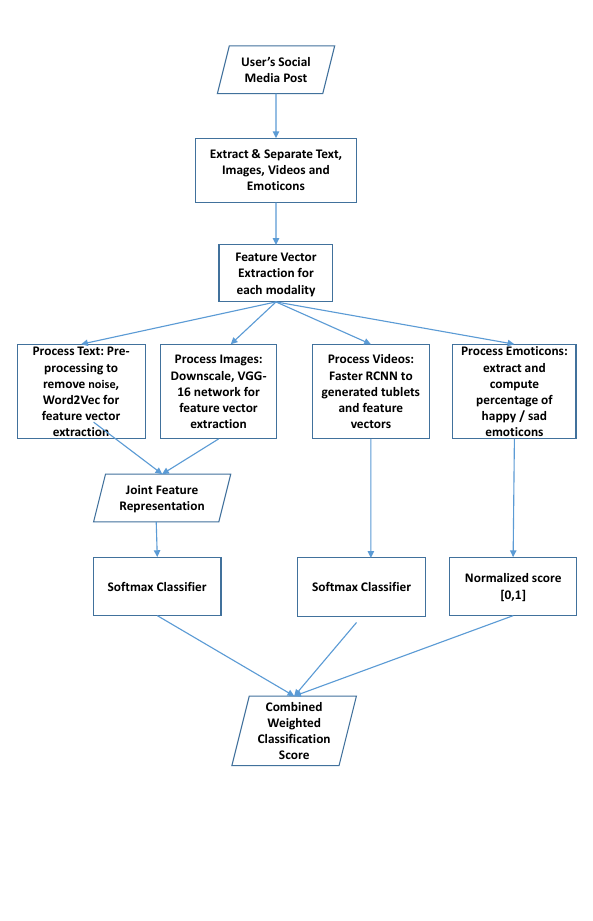
Figure 1. Flowchart for multimodal analysis of social media